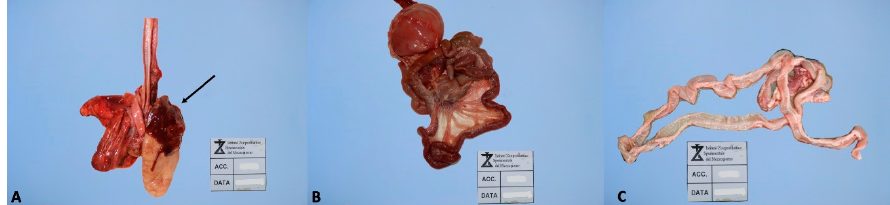
Figure 1. Pathological lesions in cases of sudden death. ( A) : pneumonia (arrows) ( B) : haemorrhagic gastroenteritis ( C) : catarrhal enteritis. gastroenteritis ( C ): catarrhal